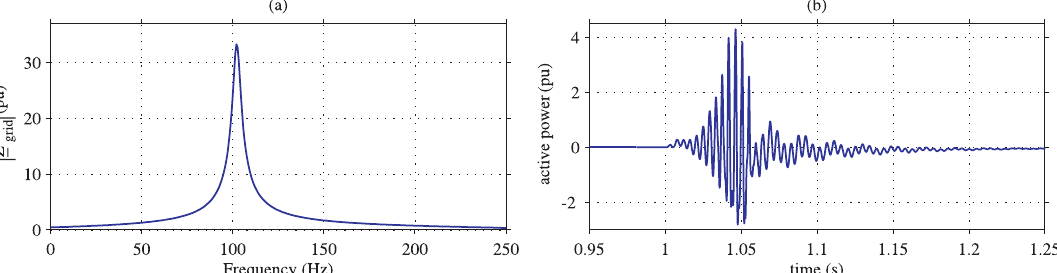
Figure 7. Impact of virtual impedance on converter-grid stability; ( a ) magnitude of grid impedance ( b ) active-power output of the converter when R v = R f , L v = L f for the time interval 1 s to 1.05 s and R v = 1.5 R f , L v = 1.5 L f for other